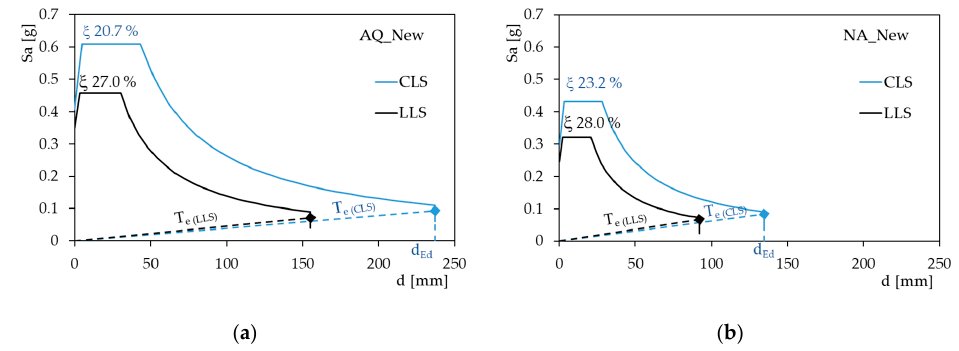
Figure 5. Isolation system design procedure on CLS and LLS spectra for the cases of New construction building in the site of L’Aquila ( a ) and Naples ( b ).